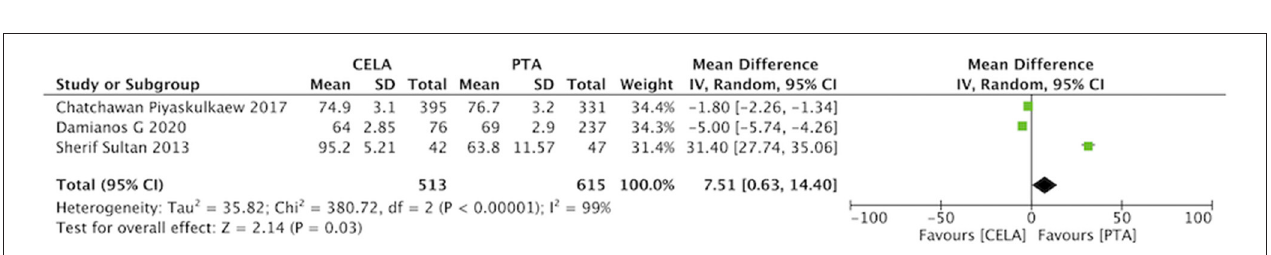
FIGURE 5 | Forest plot for freedom from TLR at 3 years. Random, a randomized effects model; CI, confidence intervals; TLR, target lesion revascularization. The green squares stand for the weight of studies in meta-analysis. Black rhomboid represents the effects of combination of above three studies.